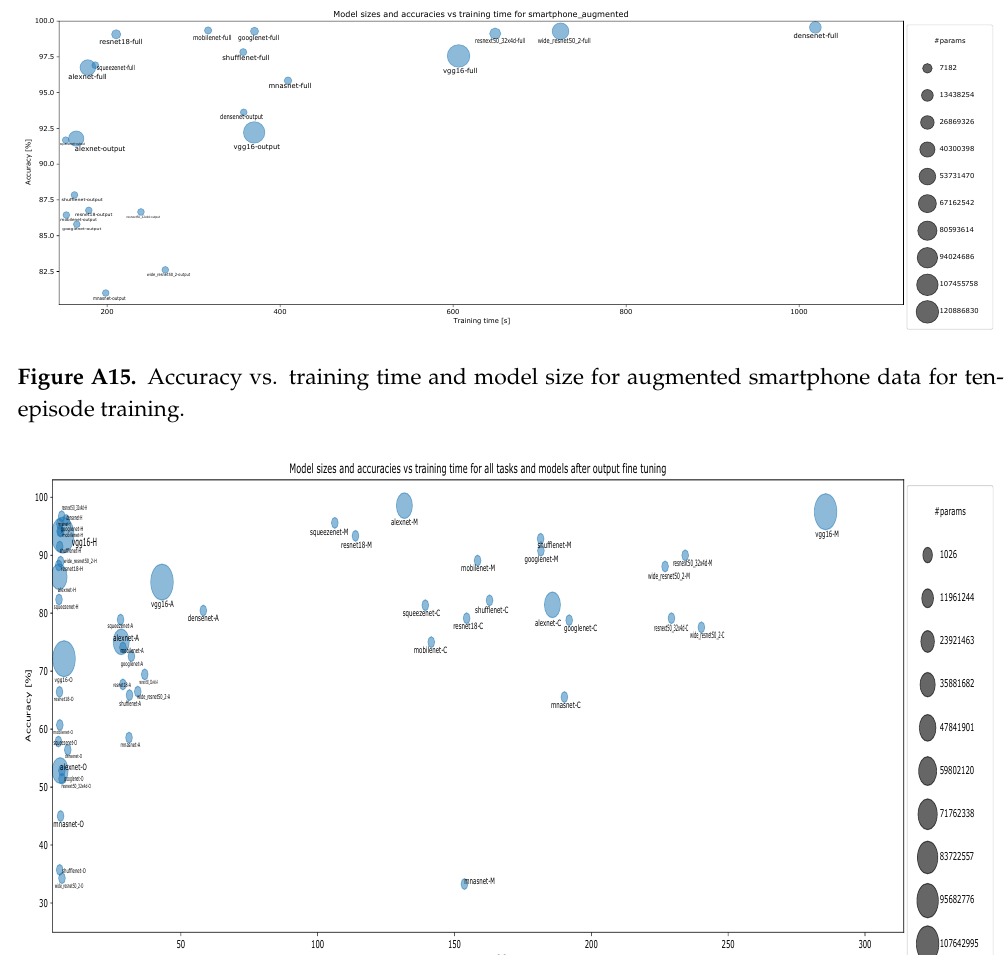
Figure A14. Accuracy vs. training time and model size for original smartphone data for ten- episode training.